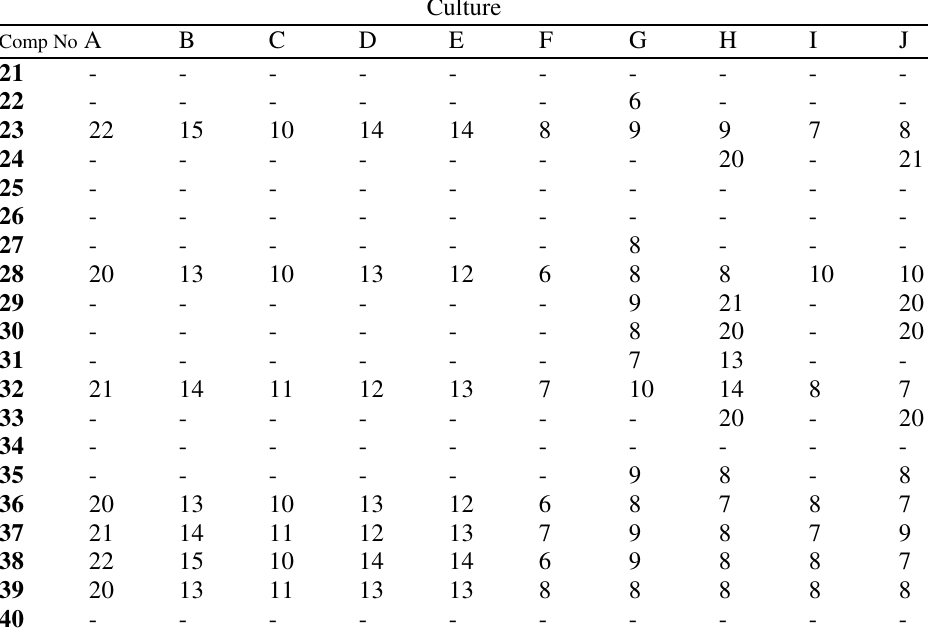
Table 1. Antimicrobial activity of 3,5-diaryl-1-benzothiazolopyrazoline